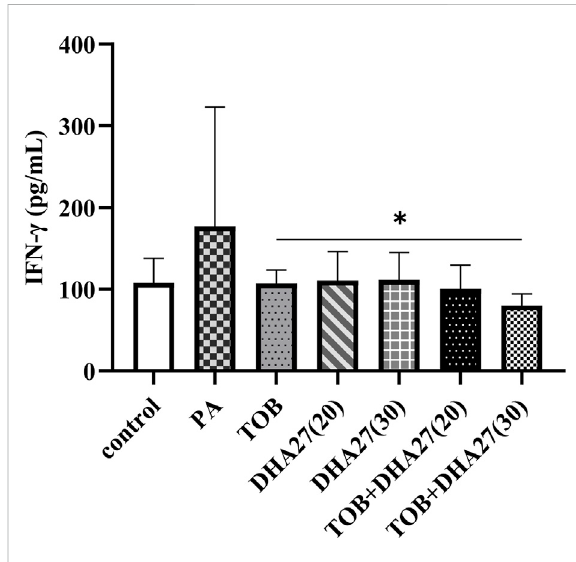
FIGURE 3 Effects of DHA27 combined with tobramycin (TOB) on the levels of interferon (IFN)- γ in the lungs of sepsis model mice (mean±standarddeviation; n =4);DHA27(20):DHA2720